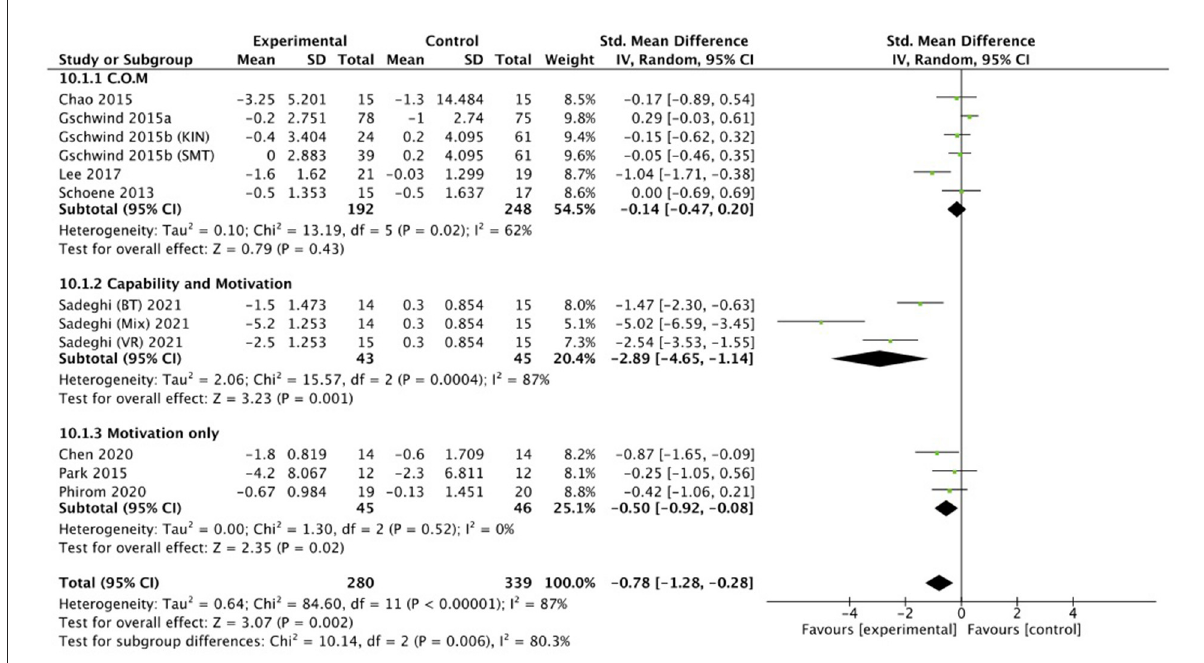
Meta-analyses of balance outcome measures